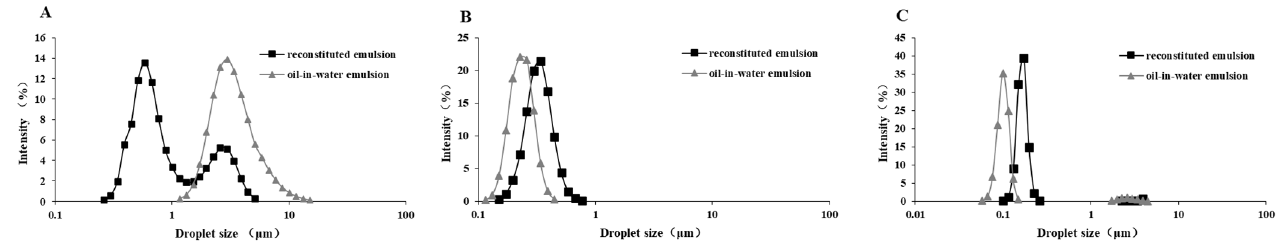
Figure 1. Droplet size distribution of sweet orange oil-in-water emulsions and reconstituted emul- sions from spray-dried powder. ( A ) LELP: Large-size emulsion and large-size powder. ( B ) SESP: Small-size emulsion and small-size powder. ( C ) NENP: Nano-emulsion and nano-size powder. The droplet sizes of the reconstituted emulsions were as follows: LP, 1.17 µ m; SP, 0.31 µ m; and NP, 0.17 µ m (Table 1). The particle size distribution of the LP after spray